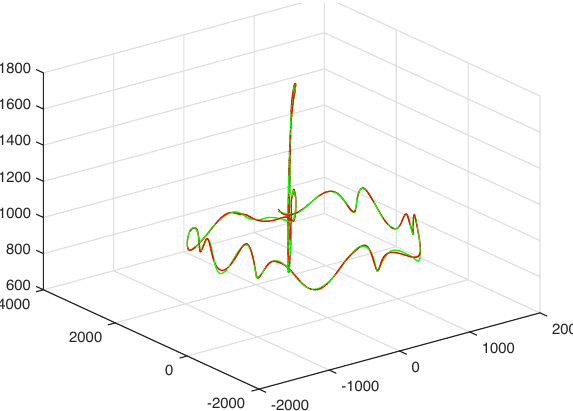
Figure 7. Three-dimensional plot of marker trajectory of the motion of the right wrist (distal; CMU 86 Trial 1). The red curve shows the experimentally observed coordinates and the green curve gives their neural approximations (with two centers and 100 satellites).